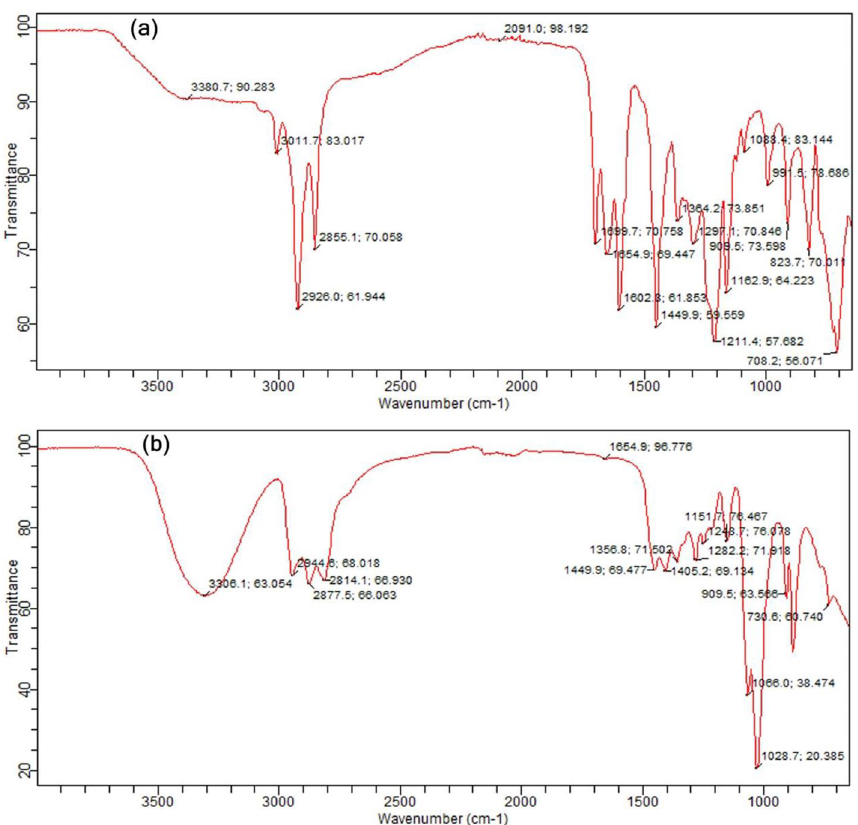
Fig. 2 FTIR spectra of natural cashew nutshell liquid (CNSL) and triethanolamine